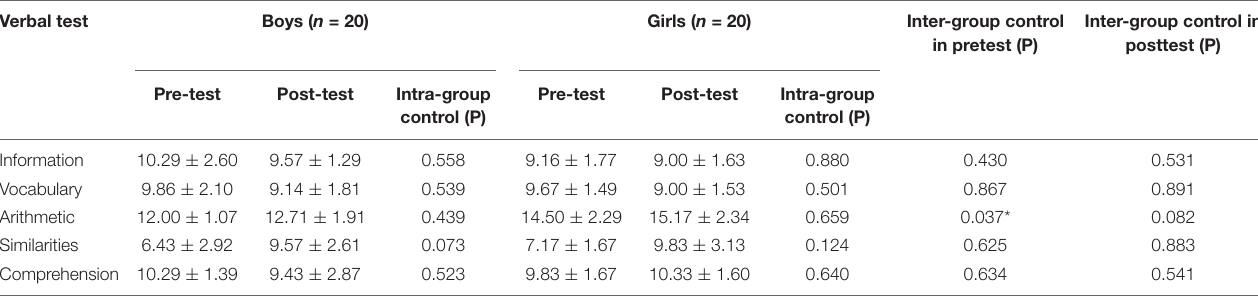
TABLE 3 | Scores of verbal test items of Wechsler Intelligence Scale in experimental class according to sex before and after the experiment. Verbal